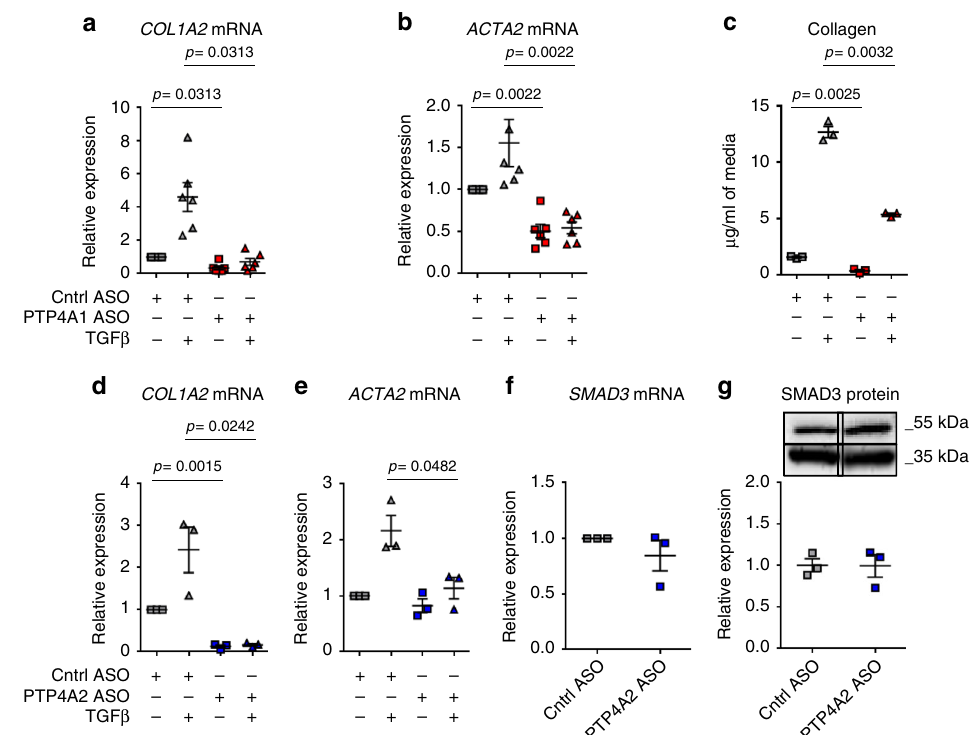
Fig. 3 PTP4A1 and PTP4A2 silencing inhibits TGF β signalings. a , b Mean ± SEM of COL1A2 and ACTA2 mRNA expression measured in six different NHDF lines treated with PTP4A1 ASO, stimulated with TGF β 1 and normalized to the same lines treated with control ASO. c Mean ± SEM of collagen concentration measured in three different NHDF lines treated with control or PTP4A1 ASO and stimulated with TGF β 1. d , e Mean ± SEM of COL1A2 and ACTA2 mRNA expression measured in three different NHDF lines treated with PTP4A2 ASO, stimulated with TGF β 1 and normalized to the same lines treated with control ASO. f Mean ± SEM of SMAD3 mRNA expression measured in three different NHDF lines treated with PTP4A2 ASO and normalized to the same lines treated with control ASO. g Mean ± SEM of densitometric scan expression plus representative immunoblotting for SMAD3 (upper bands) normalized to GAPDH (lower bands) in three different NHDF lines treated with control ASO or PTP4A2 ASO. Images are from different lanes on the same membrane. Wilcoxon test ( a , b ), Welch ’ s t -test ( c ), or Paired t -test ( d , e